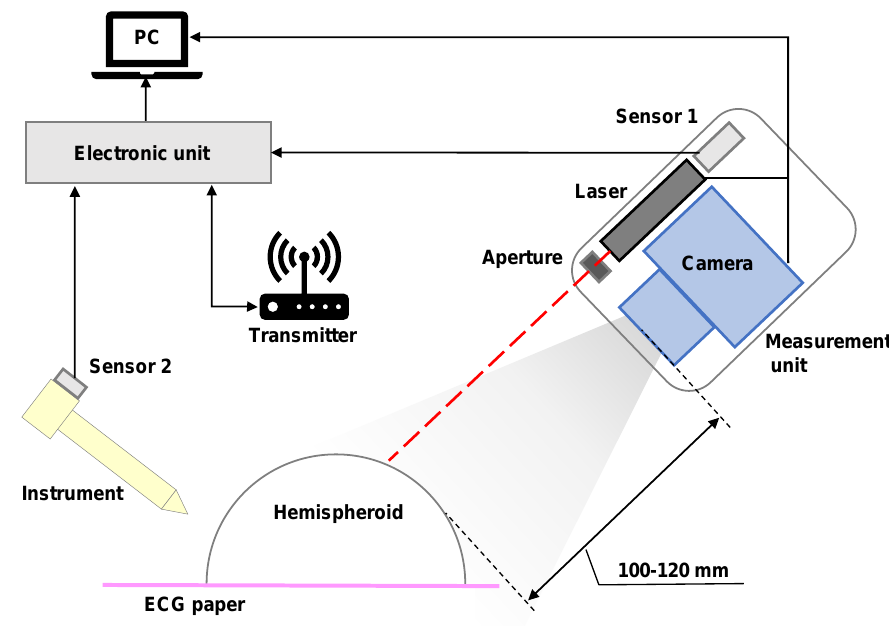
Figure 8. Experiment setup for 3D shape measurement and pose